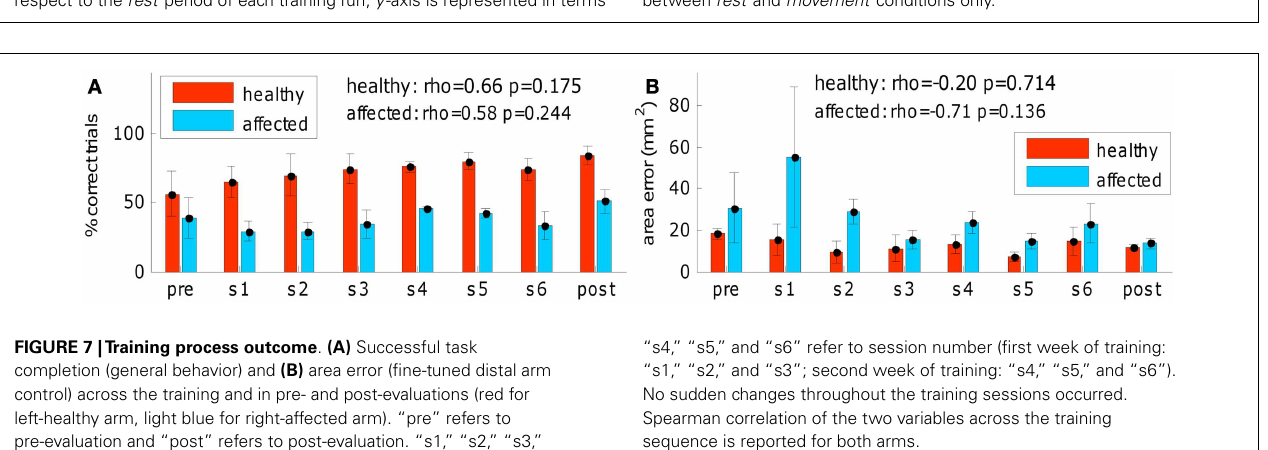
FIGURE 6 | Neuro-feedback . Neuro-feedback evolution across training and in pre- and post-evaluations: (A) left-healthy arm and (B) right-affected arm.The neuro-feedback was obtained linearly combining power spectral components of selected electrodes and normalizing (zero mean, unit variance) with respect to the rest period of each training run; y -axis is represented in terms